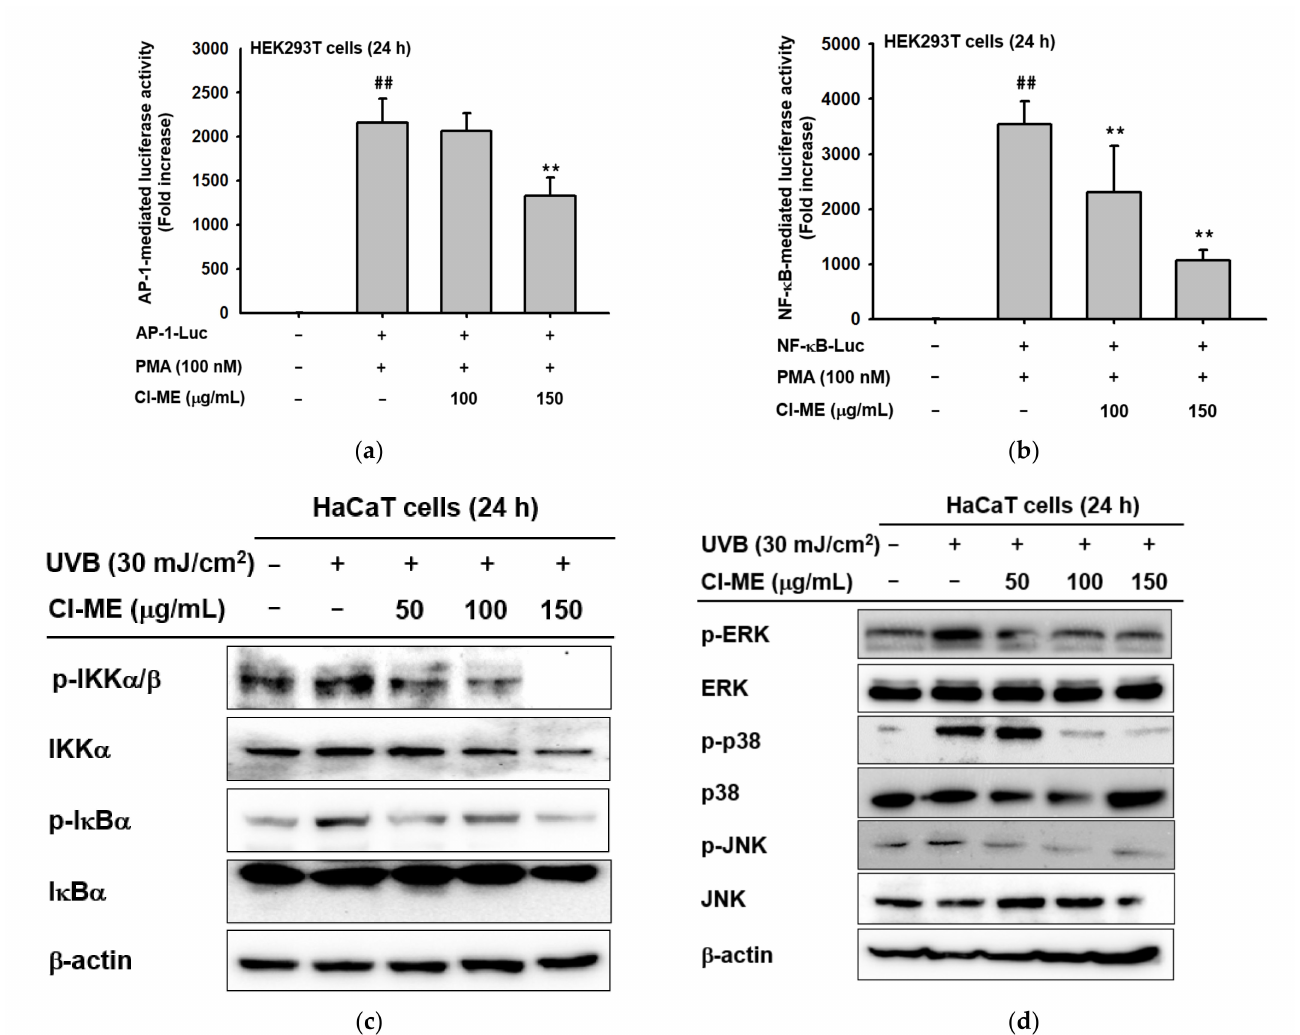
Figure 4. Cl-ME-mediated downregulation of the inflammatory NF- κ B and AP-1 pathways. ( a ) NF- κ B-mediated luciferase activity in PMA-activated (100 nM) HEK293T cells, measured after a 24 h treat- ment with Cl-ME (0–150 µ g/mL). ( b ) AP-1-mediated luciferase activity in PMA-activated (100 nM) HEK293T cells, measured after a 12 h treatment with Cl-ME (0–150 µ g/mL). ( c ) Phosphorylated and total forms of NF- κ B pathway proteins (IKK α / β and I κ B α ) obtained from UVB-treated (30 mJ/cm 2 ) HaCaT cells after a 24 h treatment with Cl-ME (0–150 µ g/mL). ( d ) Phosphorylated and total forms of AP-1 pathway proteins (ERK, JNK, and p-38) from UVB-treated HaCaT cells after a 24 h treatment with Cl-ME (0–150 µ g/mL). ## p < 0.01 compared to the normal group and ** p < 0.01 compared to the control